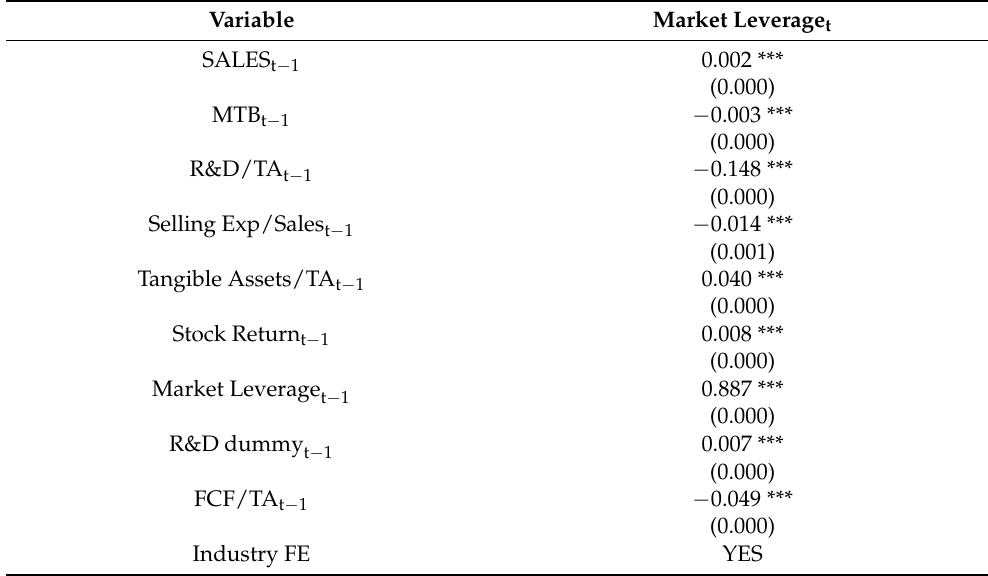
Table 2. Predicting target capital structure. We used tobit regression of market leverage in fiscal year t on SALES, MTB, R&D/TA, selling exp./sales, tangible assets/TA, stock return, market leverage, R&D dummy, and FCF/TA in fiscal year t − 1 to predict target capital structure. The value of predicted market leverage is restricted to be between 0 and 1. Variable definitions are described in Appendix A. The table shows the coefficient estimates and reports their corresponding p -values in parentheses. The symbol *** denotes statistical significance at the